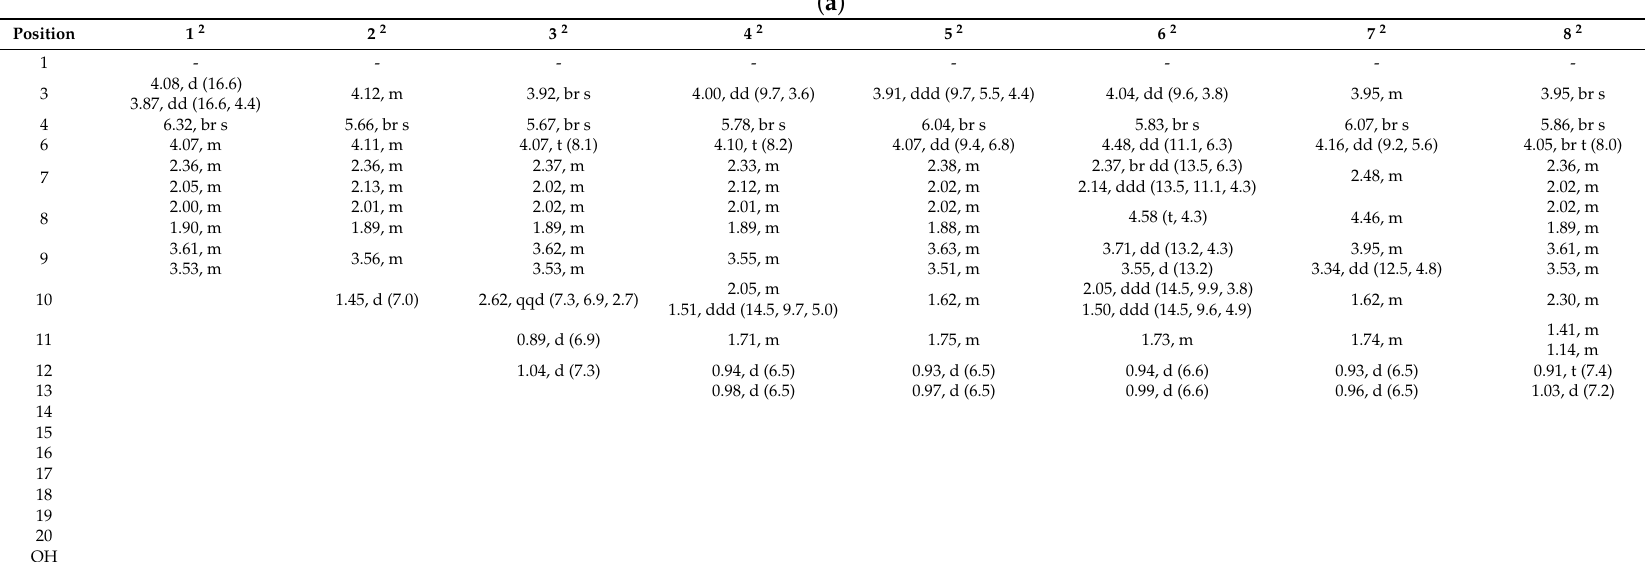
Table 1. ( a ) 1 H NMR data ( δ in ppm, J in Hz) 1 of compounds 1 – 8 . ( b ) 1 H NMR data ( δ in ppm, J in Hz) 1 of compounds 9 – 16 . ( c ) 1 H NMR data ( δ in ppm, J in Hz) 1